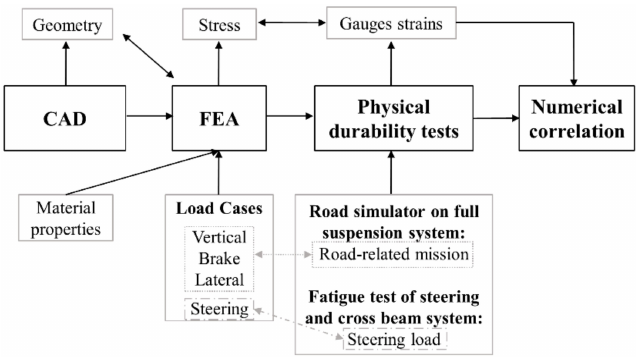
Figure 2. Flowchart of experimental and numerical development of a cross beam suspension.